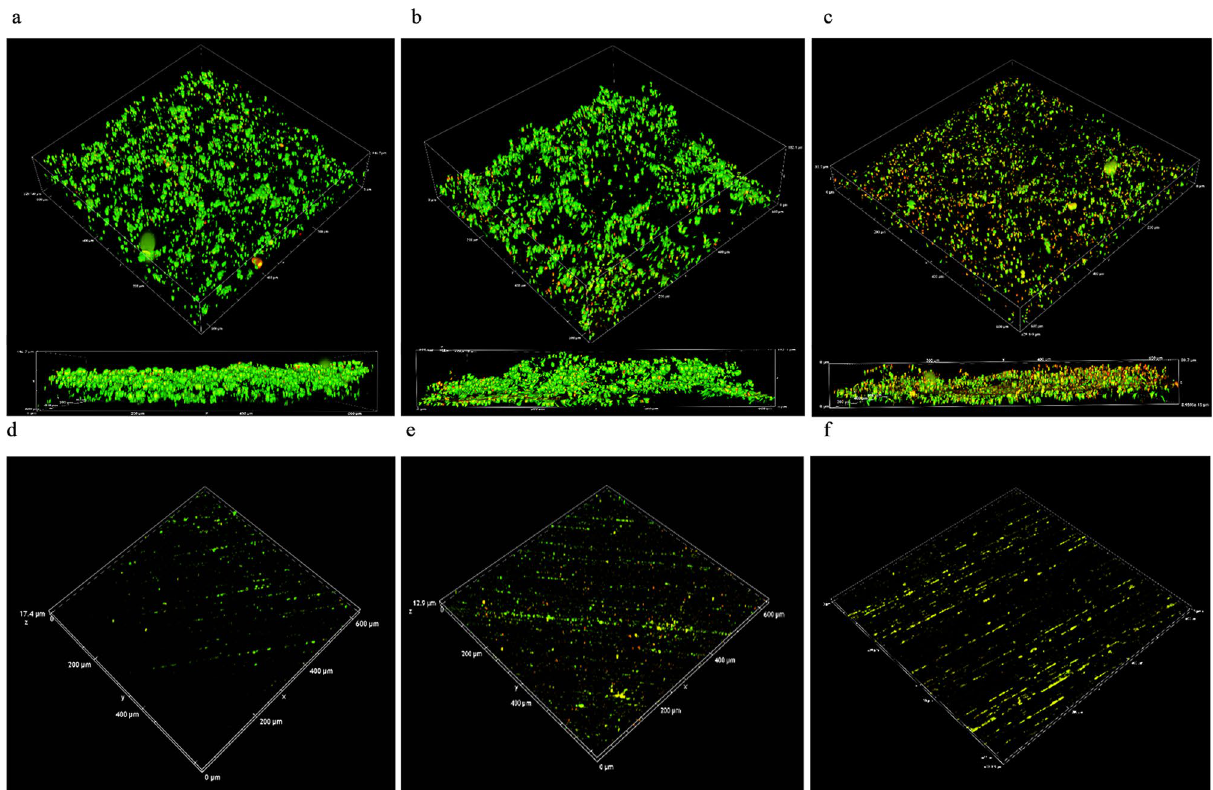
Figure 4. LIVE/DEAD confocal micrographs of attached cells on oxidised surfaces compared to wet-ground surfaces using a ×20 objective. Micrographs ( a – c ) represent S. chilikensis , K. pneumoniae and P. balearica attached to oxidised surfaces respectively. Micrographs ( d – f ) represent the isolates attached to wet-ground